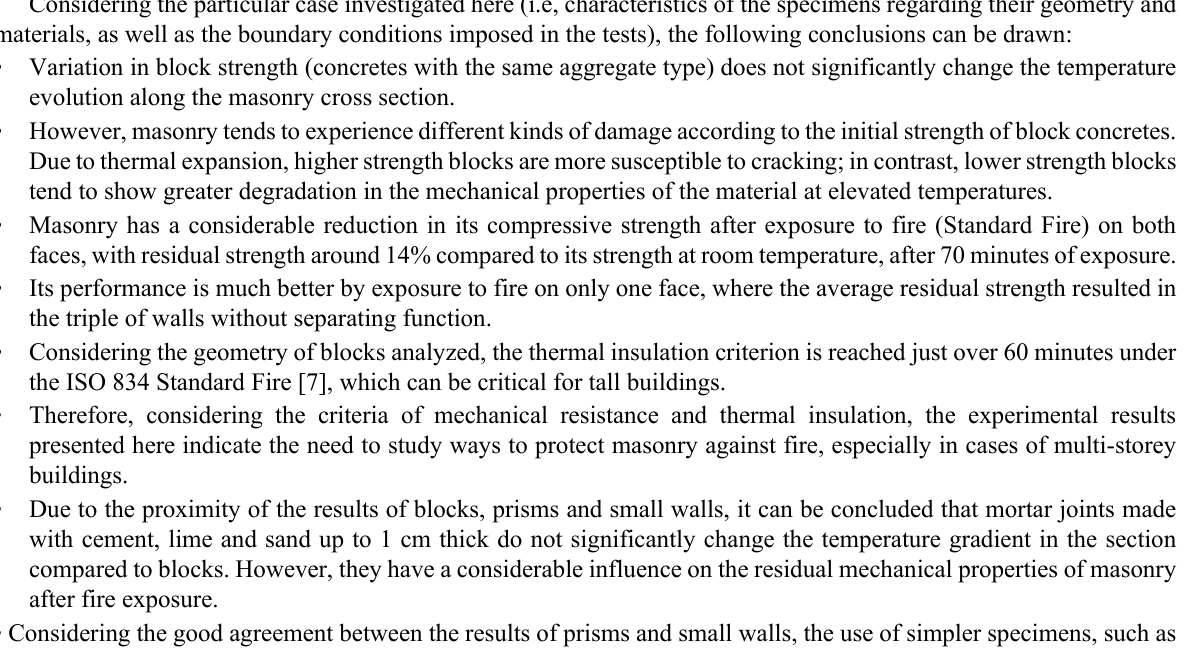
Table 4. Modulus of elasticity of small walls before and after the ISO 834 Standard Fire [7]. Blocks’ nominal strength 4 MPa